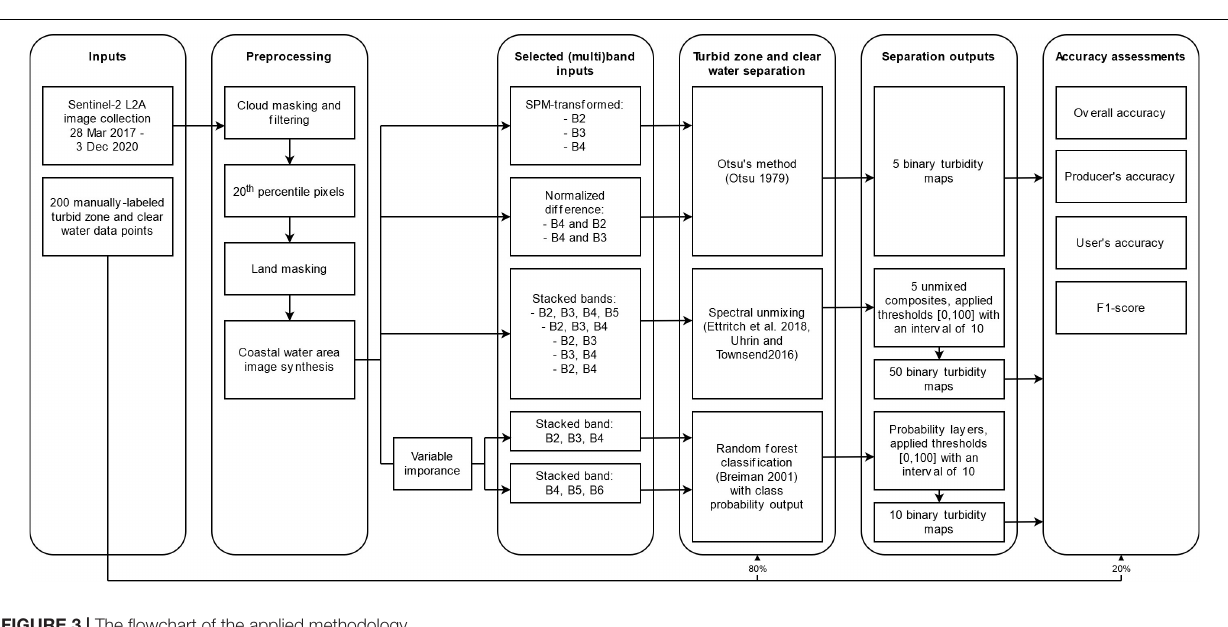
FIGURE 3 | The flowchart of the applied